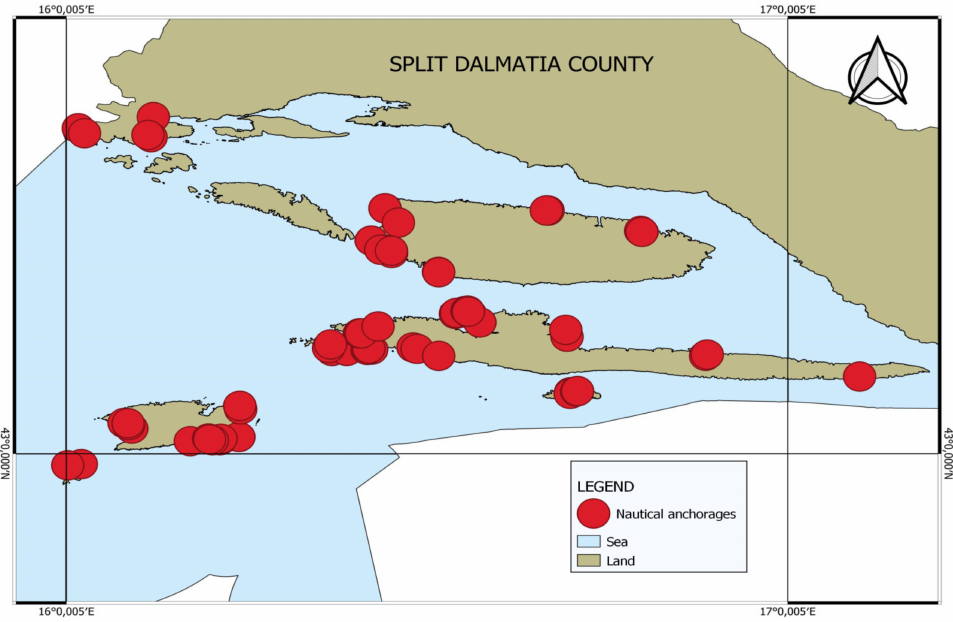
Figure 4. Spatial distribution of nautical anchorages in the area of Split-Dalmatia County.